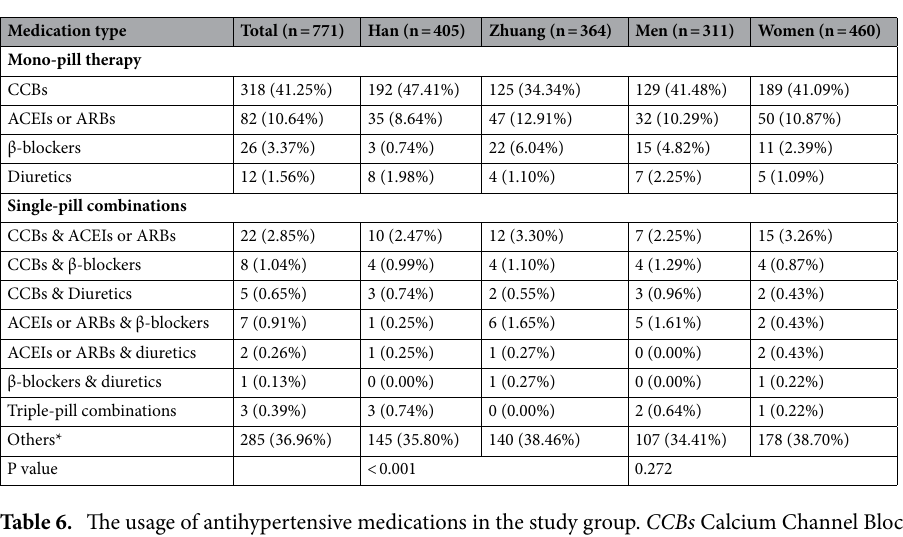
Table 6. The usage of antihypertensive medications in the study group. CCBs Calcium Channel Blockers, ACEIs Angiotensin-Converting Enzyme Inhibitors, ARBs Angiotensin II Receptor Blockers. Data are presented as n (%). *Including traditional Chinese medications, not guideline-recommended medications, and medications with unknown components.